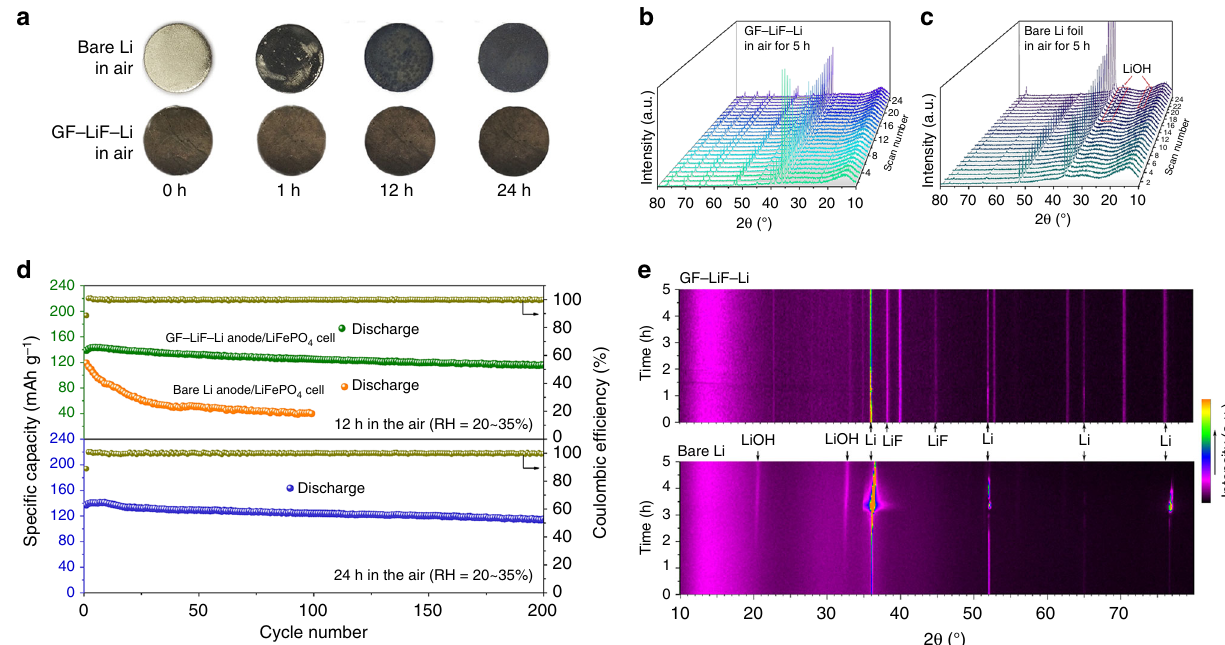
Fig. 6 Characterization of GF – LiF – Li air stability. a Photographs of pristine Li and GF – LiF – Li exposed to air with relative humidity of 20 – 35% for various times. All in situ XRD patterns of ( b ) pristine Li metal and ( c ) GF – LiF – Li at every scan. d The cycling performance of anodes after an exposure in air for 12 h (top) and 24 h (bottom). e The color plots of in situ XRD patterns of GF – LiF – Li (top) and bare Li (bottom) in air for 5